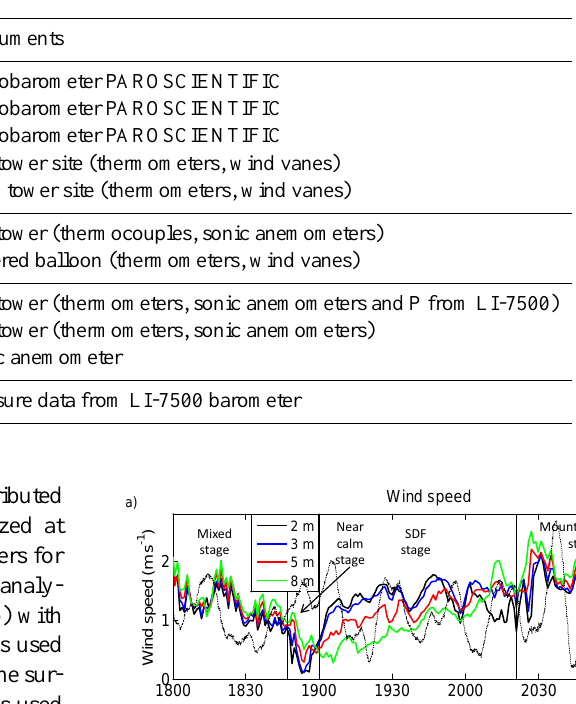
Table 2. Instrumentation used in each site.